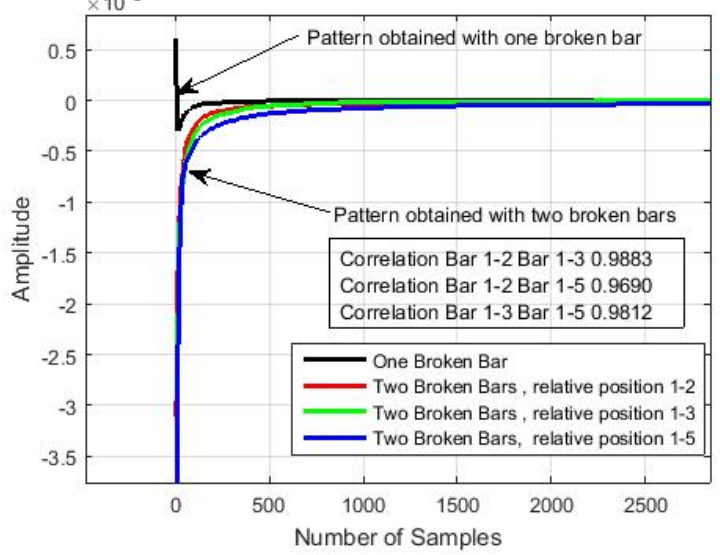
Figure 22. Zoom of the spectral pattern obtained from the application of the proposed pattern recognition algorithm showed in Figure 3, to identify broken bars.